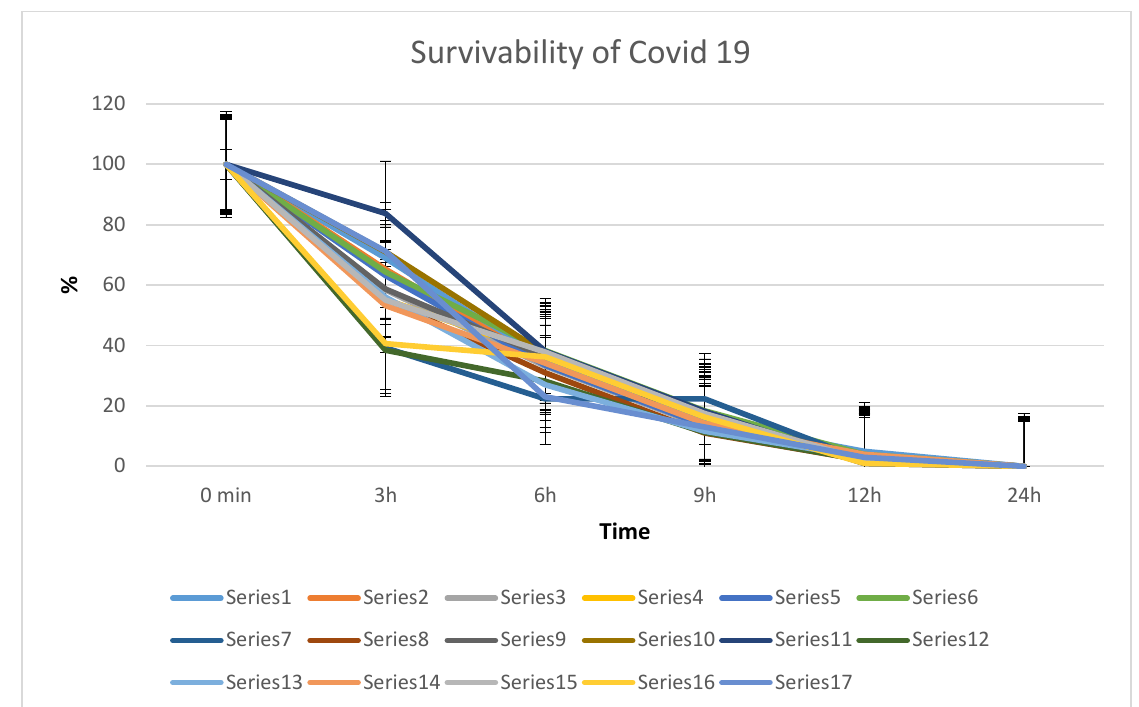
Figure 5. The survivability of SARS-CoV-2 isolated from the patients’ nasopharynx of infected individuals after Salistat SGL03 treatment on specific media plates. Series from 1 to 17 number of individual study participants (infected persons by SARS-CoV-2), (see Section 2.1).